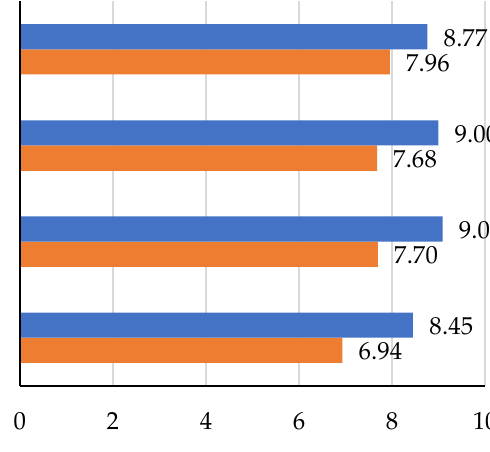
Table 6. Results of comparing managers’ self-assessment with workers’ assessment of managers.